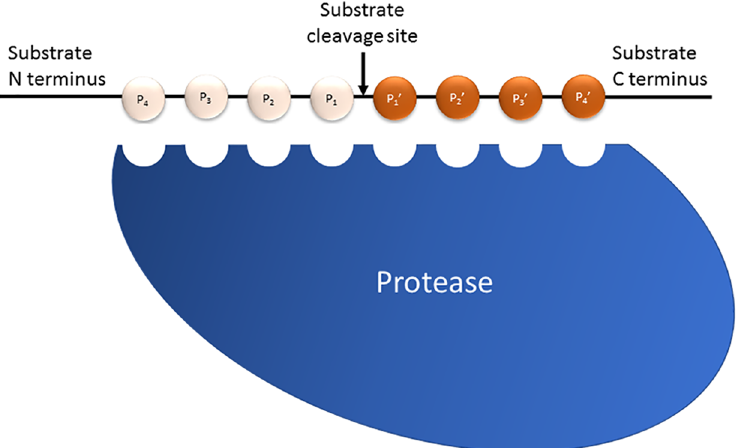
Fig 1. Protease substrate specificity in which P1 to P3 represent amino acid side chains from the site of peptide bond cleavage (hashed line) to N terminus of protein or peptide. P1’ to P3’ represent amino acid sidechains from cleavage site to C terminus. The nomenclature was first defined by Schecter and Berger